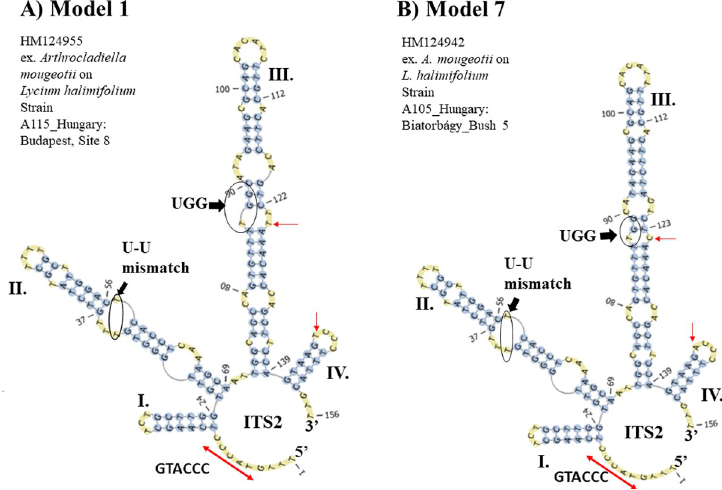
Fig 5. The most common ITS2 S2 (Model 1) found in the Ampelomyces population. (A) The ITS2 S2 Model 1 derived from Ampelomyces extracted from seven PM genera. (B) The ITS2 S2 Model 7 derived from Ampelomyces extracted from A . mougeotii . Compared to Model 1, Model 7 contains several nucleotide substitutions. Specifically, nucleotides cytosine and uracil in helices III and IV, respectively of Model 1 are present as uracil and thymine in the helices III and IV, respectively of Model 7; (red arrows indicate nucleotide substitutions). The helices are indicated by Roman numerals (I–IV). The following shared ITS2 features are shown in black arrows and circles: (1) a U-U mismatch on helix II and (2) the UGG motif on helix III. A single-stranded ring between helices I and IV is indicated with red left right arrows. It comprises the sequence GTACCC or � UACCC when T is substituted with U. The structures were directly folded and modelled using the